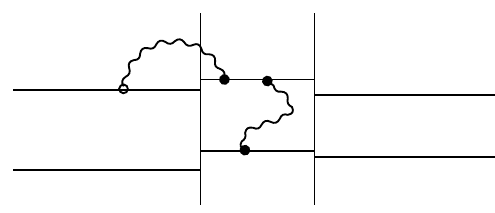
Figure 1 . Brane configuration for N = 2 SYM with SU(2) gauge group: the QFT lives on a stack of two D4-branes (horizontal lines) suspended between two non dynamical NS5-branes (vertical lines). The four external D4 flavour-branes extending to infinity provide the matter hypermultiplets of the